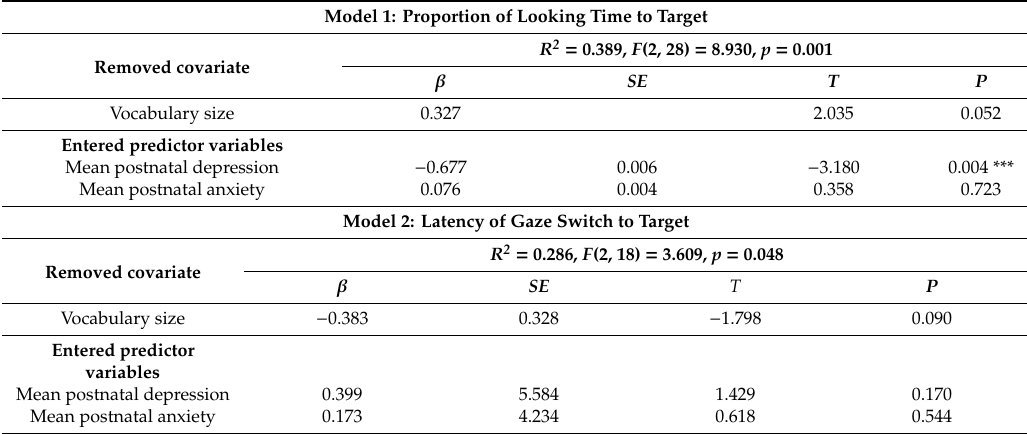
Table 3. Hierarchical linear regression models with proportion of looking time to target post-naming (Model 1) and latency of gaze switch to target (Model 2) as dependent variables. Model 1: Proportion of Looking Time to